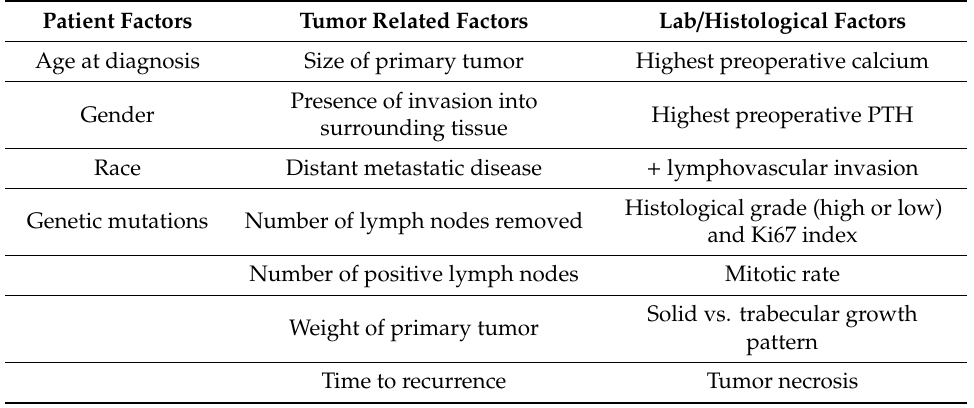
Table 2. Variables for proposed staging system for parathyroid cancer (AJCC /